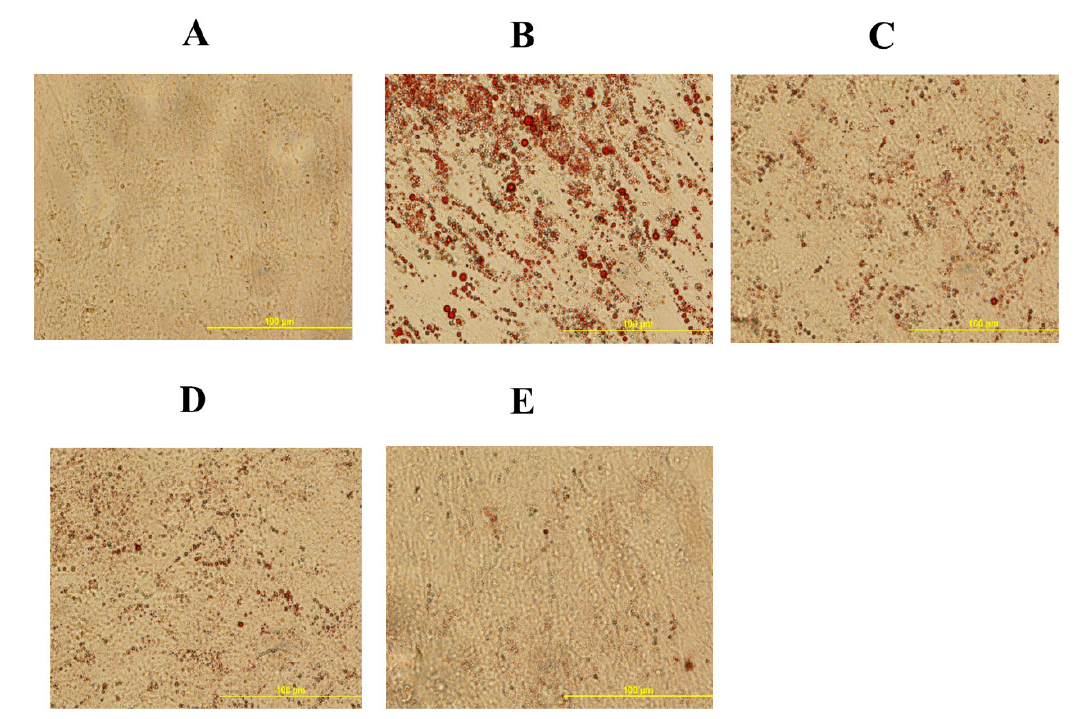
Figure 5. 20S inhibits adipogenic di ff erentiation of mesenchymal stem cells isolated from compact bones of chicken. Cells were treated with ( A ) Control, ( B ) Oleic acid media (OA), ( C ) OA + 2.5 µ M 20S, ( D ) OA + 5 µ M 20S, or ( E ) OA + 10 µ M 20S for 96 h. Adipocyte formation was examined by Oil Red O staining procedure. Pictures were taken by Olympus DP70 at 20X.